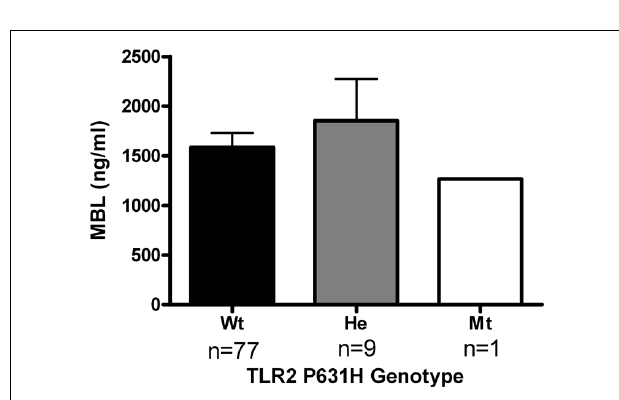
FIGURE 3 |Analysis on the mannose-binding lectin (MBL) concentrations in serum obtained from RVVC patients bearing the wild-type or the variant allele of the TLR2 polymorphism Pro631His. Wt, wild-type; He, heterozygous. Data are presented as means ± SEM.